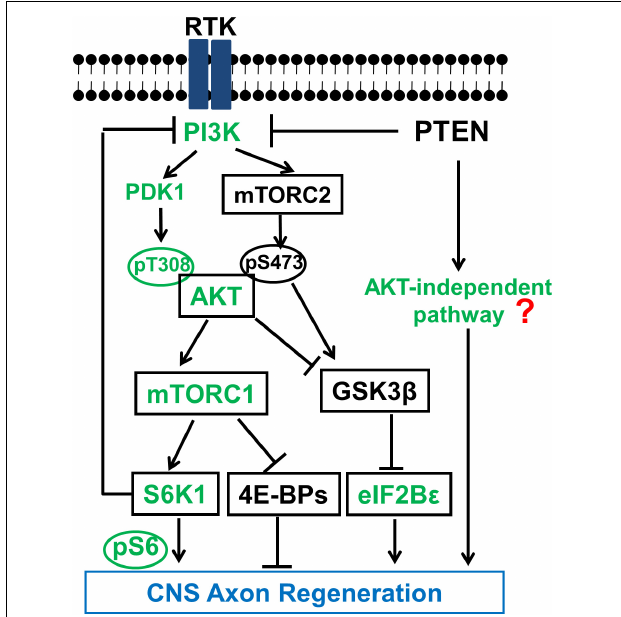
FIGURE 2 | Schematic illustration of the PTEN regulated PI3K-AKT-mTOR signaling pathways in CNS axon regeneration. AKT is positively regulated by the PI3K/PDK1 pathway through phosphorylation of T308, and negatively regulated by the PI3K/mTORC2 pathway through phosphorylation of S473, through at least partially regulation of GSK3 β phosphorylation and inhibition. Both AKT downstream effectors, activation of mTORC1 and phosphorylation/inhibition of GSK3 β , synergistically promote axon regeneration; inhibition of GSK3 β alone is also sufficient for axon regeneration, at least partially through eIF2B ε . The activation of mTORC1 and its substrates 4E-BP and S6K is necessary but not sufficient for potent axon regeneration. The question mark represents unknown effectors downstream of PTEN that are AKT-independent and sufficient to initiate CNS axon regeneration, and which potentially interact with the translational targets of mTORC1 to promote potent axon regeneration. Green color-coated molecules are pro-axon regeneration and dark color-coated molecules are anti-axon